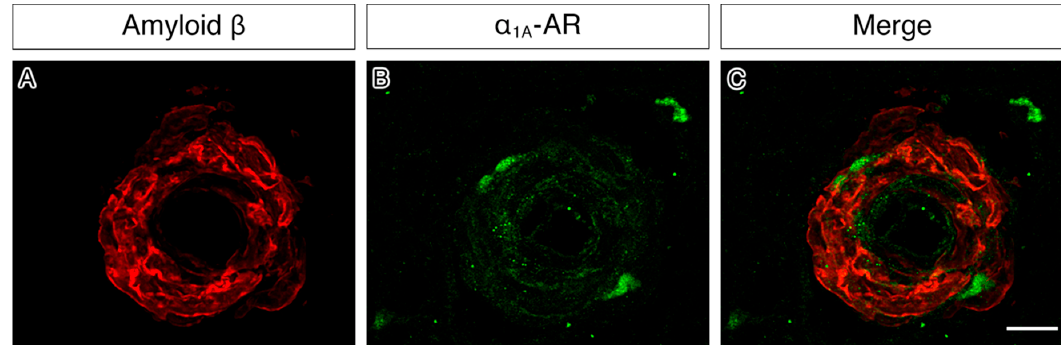
Figure 4. Immunofluorescence for α 1A -AR ( green ) and A β ( red ) on sections of human occipital cortex of a case of CAA. The green immunofluorescence is present within the endothelium and in between the amyloid deposits of the wall of the vessel. Based on the diameter of the vessel and the thickness of the vessel wall, as well as the presence of CAA mainly in cortical arterioles, the vessels are arterioles of 10 µm diameter. Scale bar 25 µm. ( A ) immunostaining for A β occupying the whole of the vessel wall in a circumferential manner ( B ) immunostaining for α 1A -AR showing a focal distribution ; ( C ) the overlay image of both A β and α 1A -AR immunofluorescence .